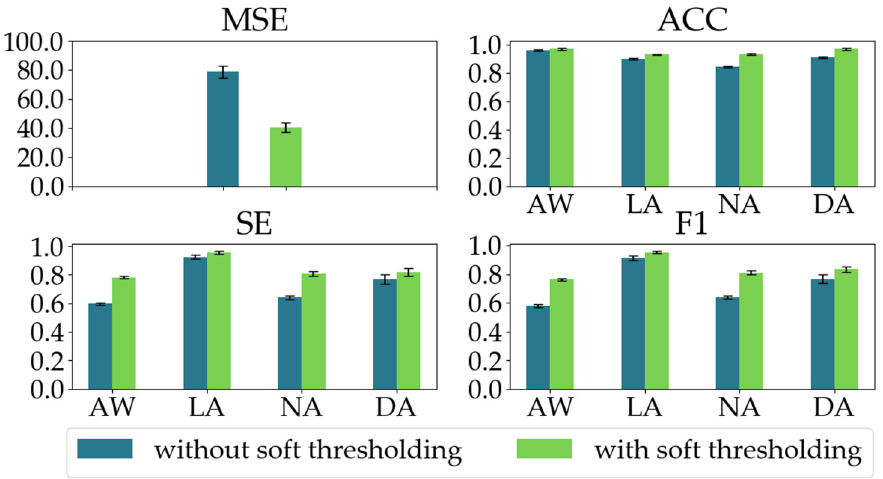
Figure 10. The regression and classification performances of the two models in the ablation experi- ment on the soft thresholding module in the RSBU-CW.